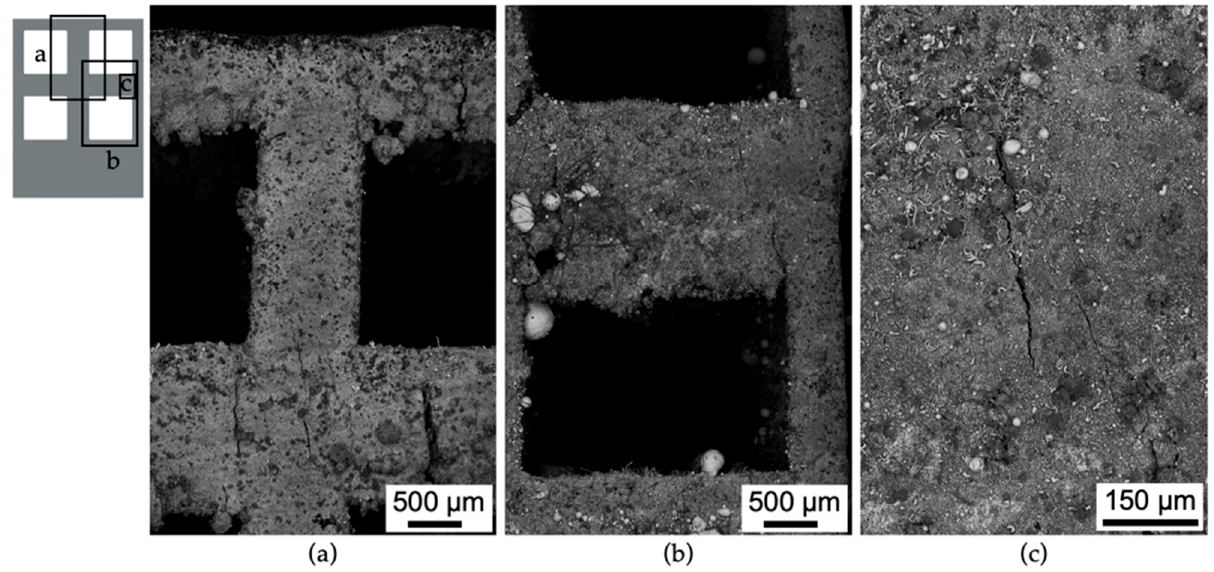
Figure 12. SEM micrographs (SE) of lattice structure surface before ( a ) and after ( b , c ) thermal cycling. The schema shows micrographs position.